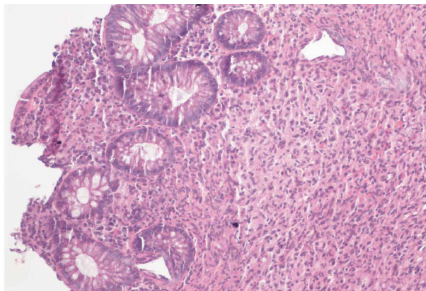
Figure 2: Rectal biopsy showing diffuse expansion of lamina propria with infiltration by lymphohistiocytic cells. ( 𝐻 and 𝐸 , magnification ×200).